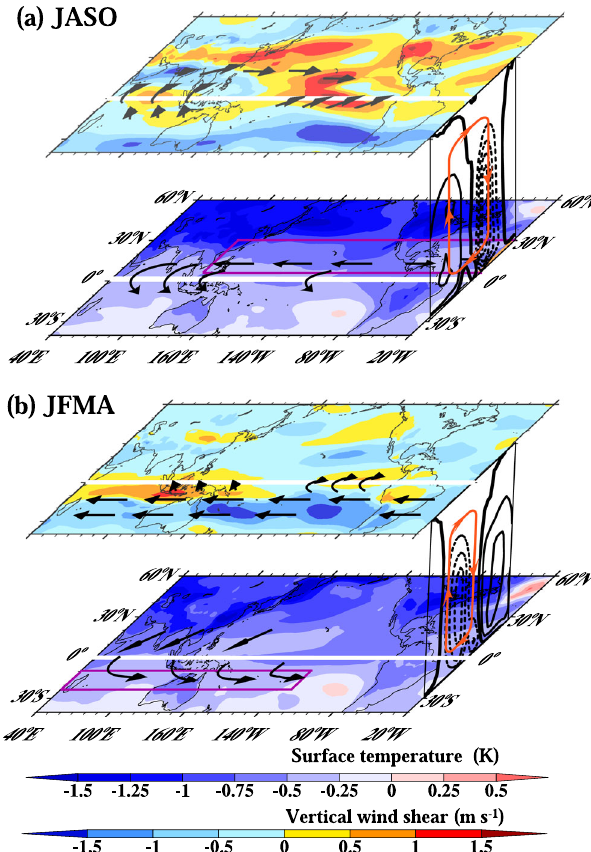
Fig. 5 Schematic diagram illustrating the historical anthropogenic aerosol-forced circulation changes between the pre-Industrial period (1850 – 1879) and modern period (1985 – 2014). a Northern Hemisphere tropical cyclone (TC) season (July-October, JASO), b Southern Hemisphere TC peak season (January – April, JFMA). In each panel, the low-level map shows the changes of surface temperature (shaded, K). The upper-level map shows the change of vertical wind shear (shaded, m s − 1 ). The arrows highlight the cross-equatorial fl ow and associated rotational fl ow changes. The right-side vertical cross-section shows the climatological Hadley cell measured by vertical pressure velocity (contours) and aerosol-induced change (red lines). The NH-cooler-than-SH pattern produces a low-level southward cross-equatorial transport of moist static energy, weakening the NH ascent while strengthening the SH ascent. The NH-increased and SH- decreased meridional temperature gradients strengthen vertical wind shear in the NH but reduce the vertical wind shear in the SH. The less (more) favorable TC formation environment suppresses (promotes) the formation of NH (SH)